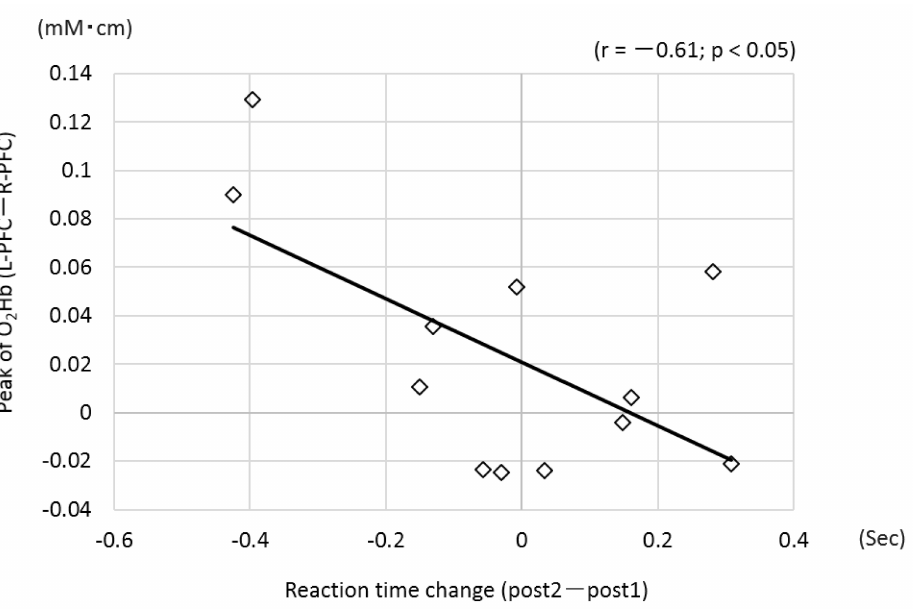
Figure 5. Correlation between differences in the peak levels of O 2 Hb in the L-PFC and R-PFC and the variation in reaction time. The horizontal axis represents the reaction time, and the vertical axis represents the difference between the peak O 2 Hb levels in the L-PFC and R-PFC. O 2 Hb: oxygenated hemoglobin.